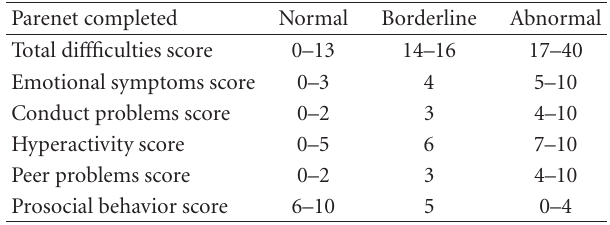
Table 1: SDQ classified